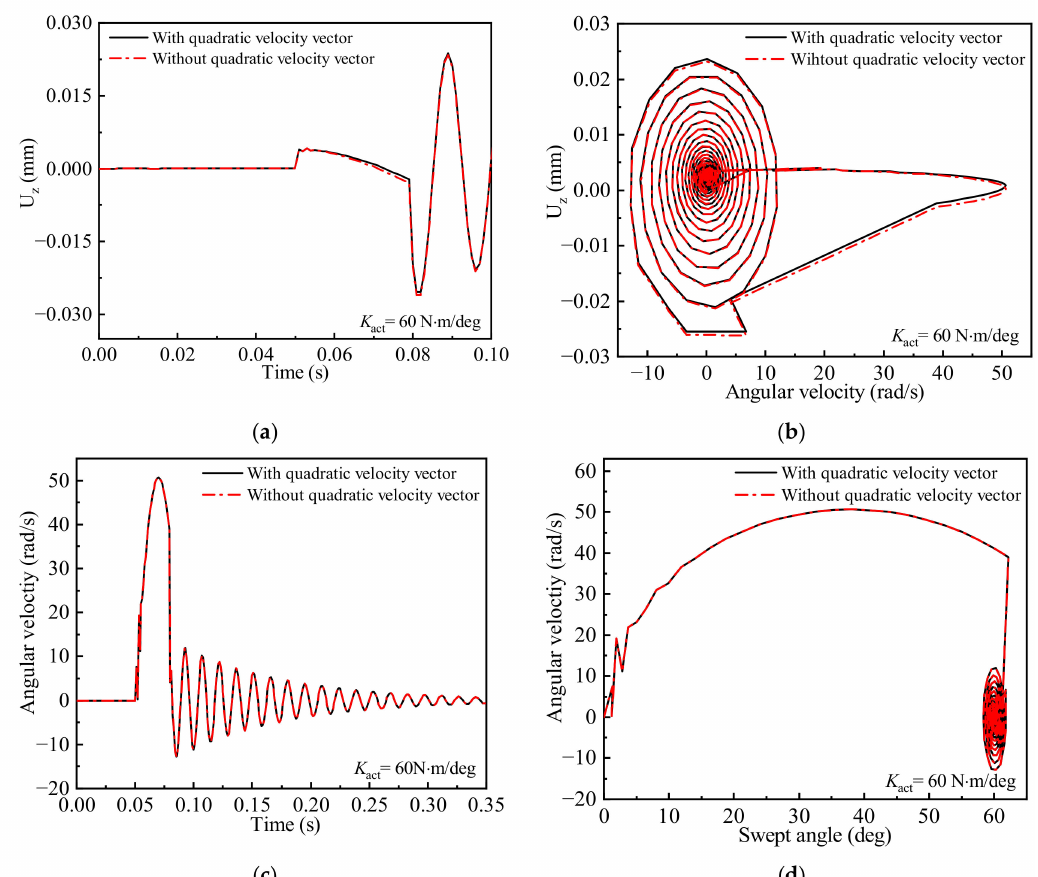
Figure 26. Effect of the quadratic velocity term on the displacement responses, K act = 60 N · m/deg. ( a ) Z-displacement vs. time. ( b ) Z-displacement vs. angular velocity. ( c ) Angular velocity vs. time. ( d ) Angular velocity vs. sweep